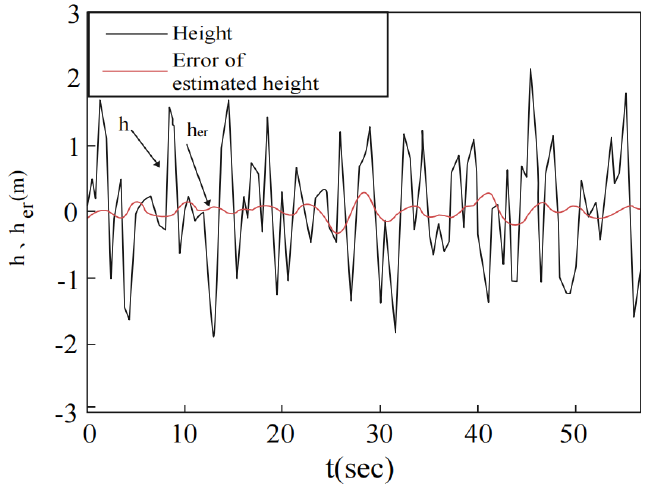
Figure 8. Height of ideal landing point and its estimated value (encounter angle of 2 π /3, level − 5 sea state, navigation speed of 18 knots).